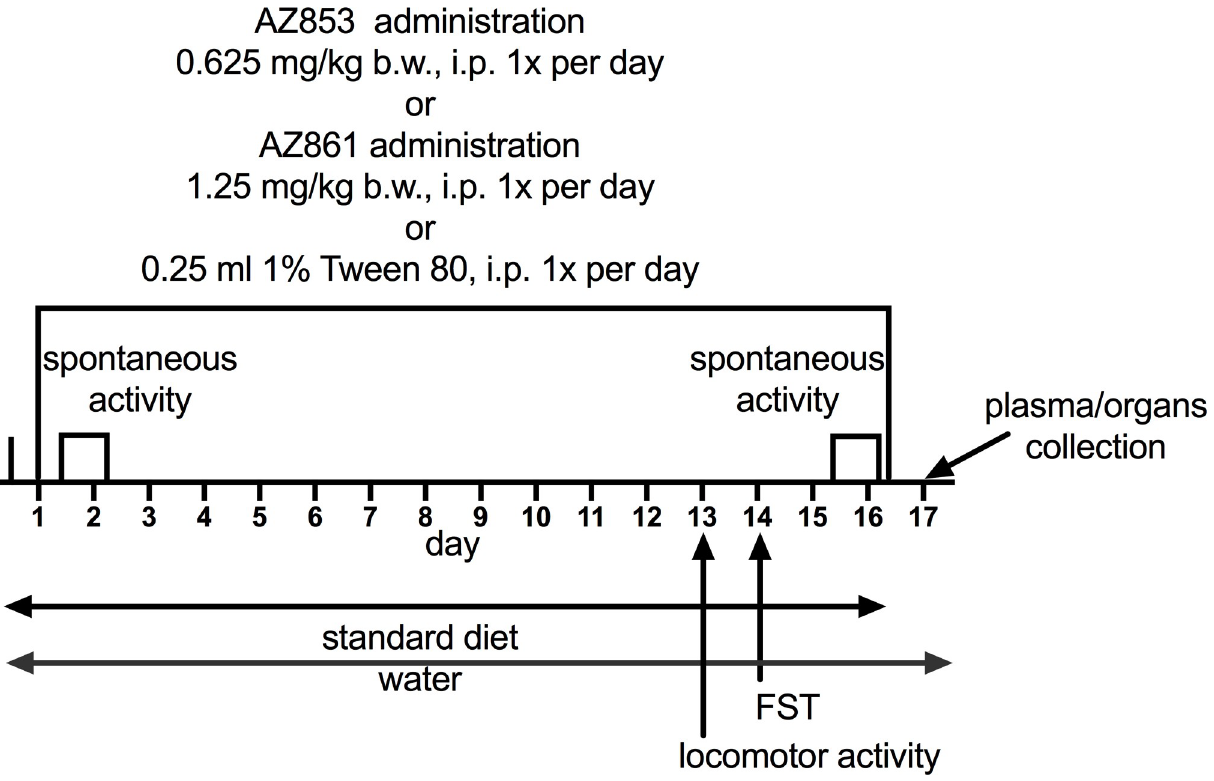
Fig 2. Scheme of seventeen-day experimental